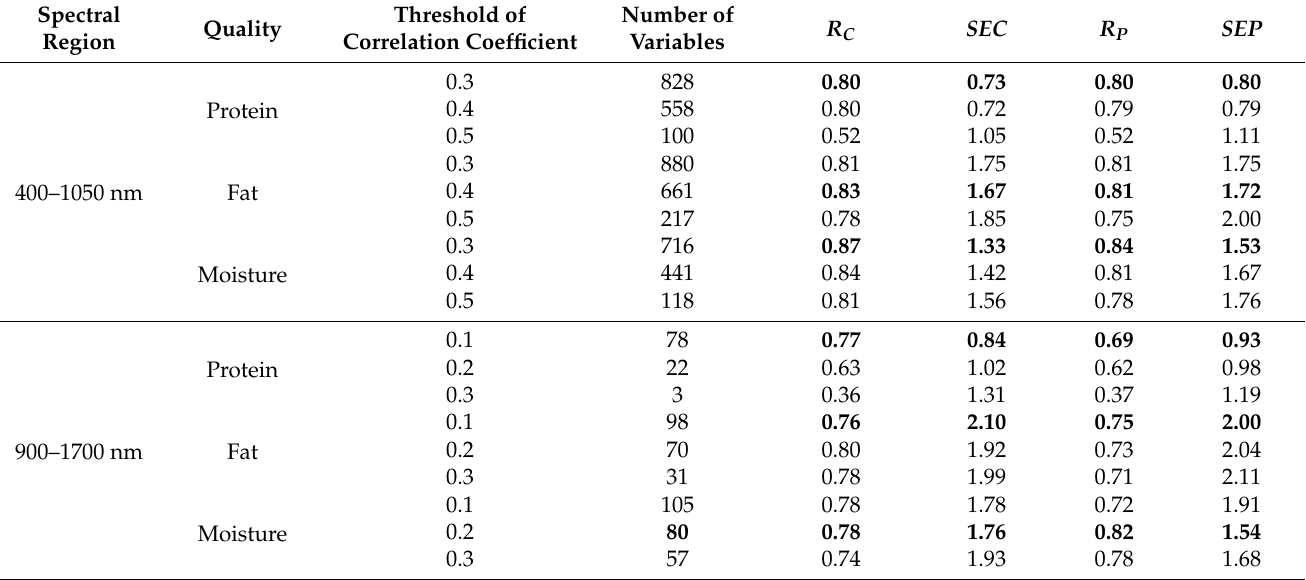
R C —correlation coefficient of calibration set, R P —correlation coefficient of prediction set, SEC —root mean square error of calibration set, SEP —root mean square error of prediction set; Bold refers to the model selected due to possessing the lowest R P